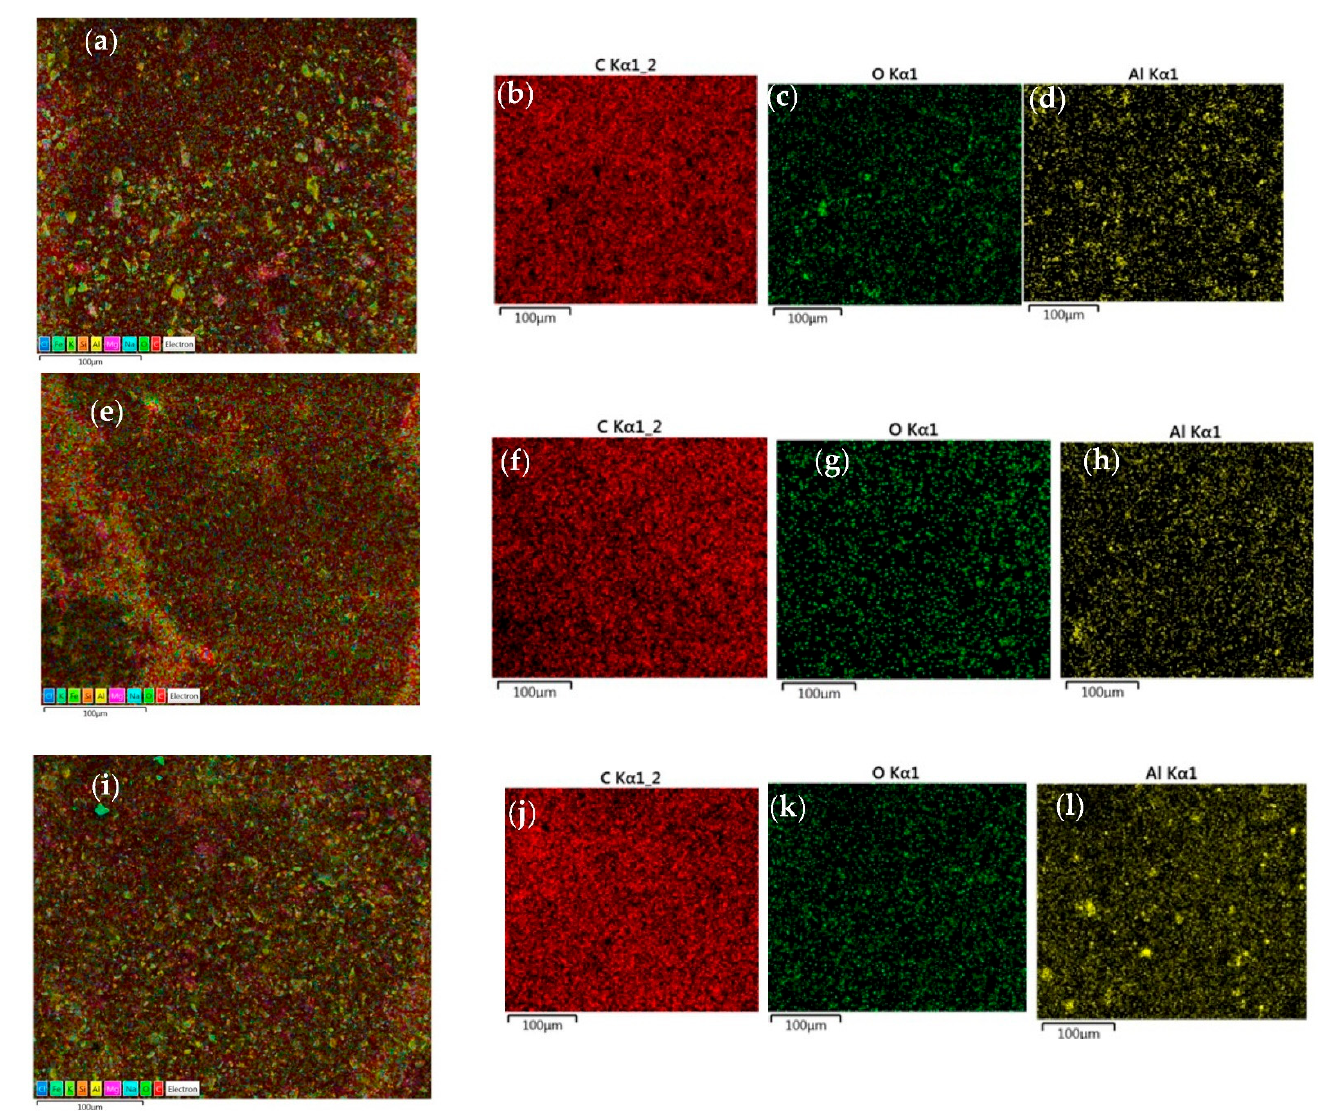
Figure 7 . EDS mapping of the epoxy matrix ( a ) without adding Al NP, with ( e ) 1.0% Al NP and ( i ) 6.0% Al NP. Overview of the distribution of carbon (C), oxygen (O), and aluminium (Al) in epoxy coating ( b – d ) without adding Al NPs and with ( f – h ) 1.0% Al NP and ( j – l ) 6.0% Al NP.